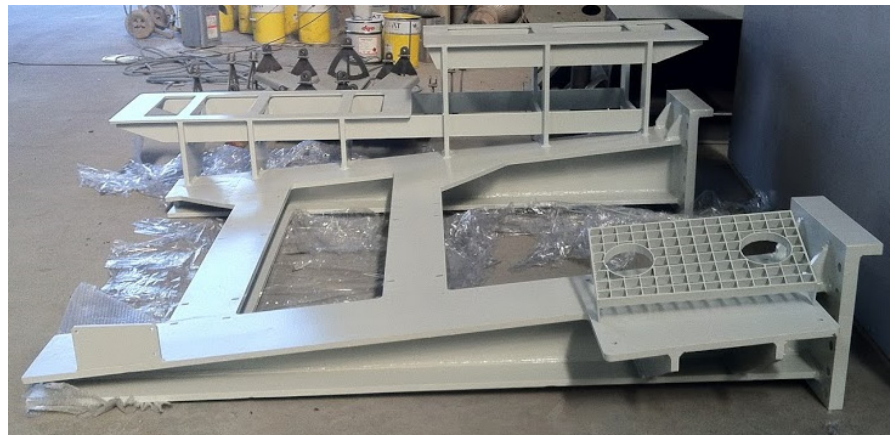
Figure 16. Completed welded part of the hybrid bedplate.